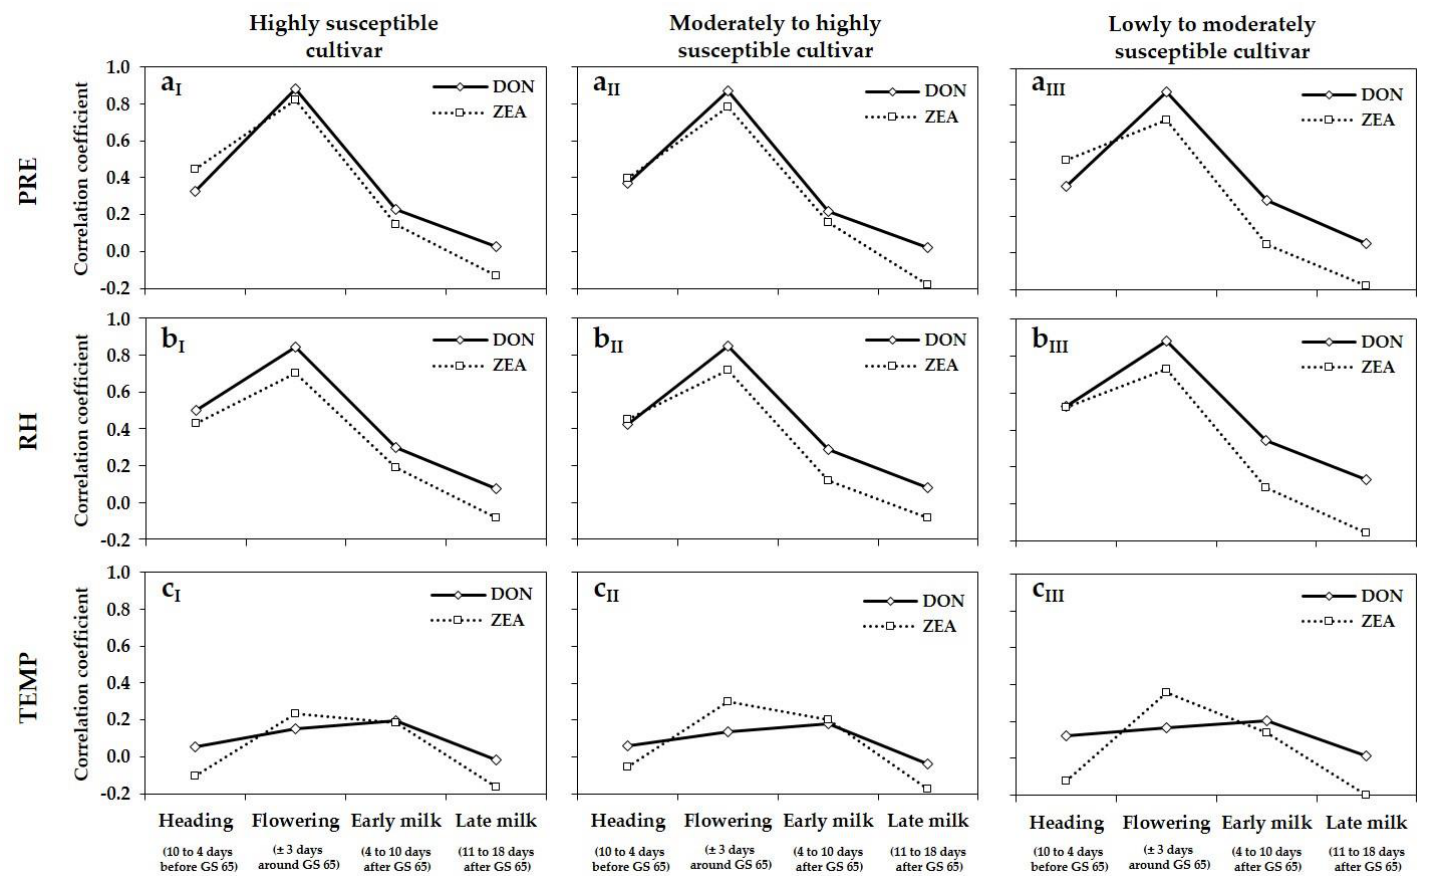
Figure 6. Curves of correlation coefficients ( r ) between meteorological variables ( a ) PRE (cumulative precipitation, mm), ( b ) RH (relative humidity, %) and ( c ) TEMP (mean temperature, °C) and DON and ZEA concentrations (µg/kg) in wheat grain 10 to 4 days before GS 65 (heading), ± 3 days around GS 65 (flowering), 4 to 10 days after GS 65 (early milk stage) and 11 to 18 days after GS 65 (late milk stage) of the highly (I), the moderately to highly (II) and the lowly to moderately susceptible cultivar (III) of the seven trial locations (three replications per location) in northern Germany summarized for the years 2013 to 2017. n = 315.